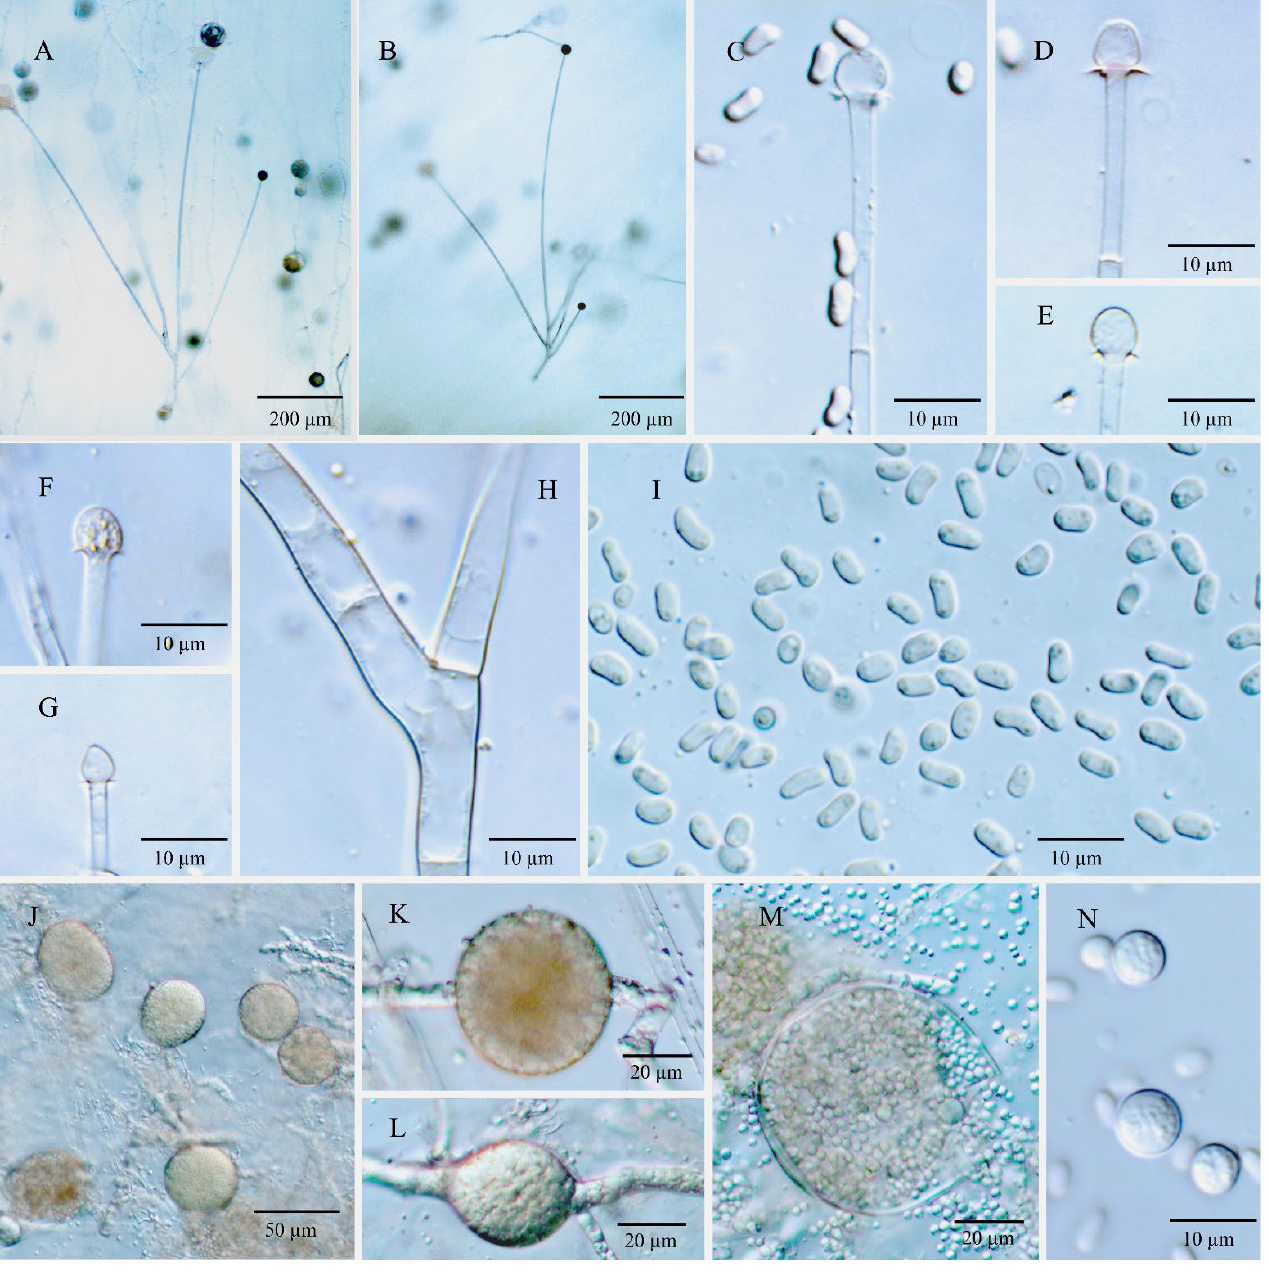
Figure 6. Umbelopsis oblongielliptica . ( A , B ) Branched sporangiophores. ( C – G ) Various shapes of collars and columellae at sporangiophore tips after the sporangia have been dissolved. ( H ) Branch point of sporangiophore. ( I ) Sporangiospores. ( J – M ) Various macro-chlamydospores. ( K ). Mature macro-chlamydospores, ( L ). Immature macro-chlamydospores, ( M ). Broken macro-chlamydospore spilling oil droplets. ( N ).